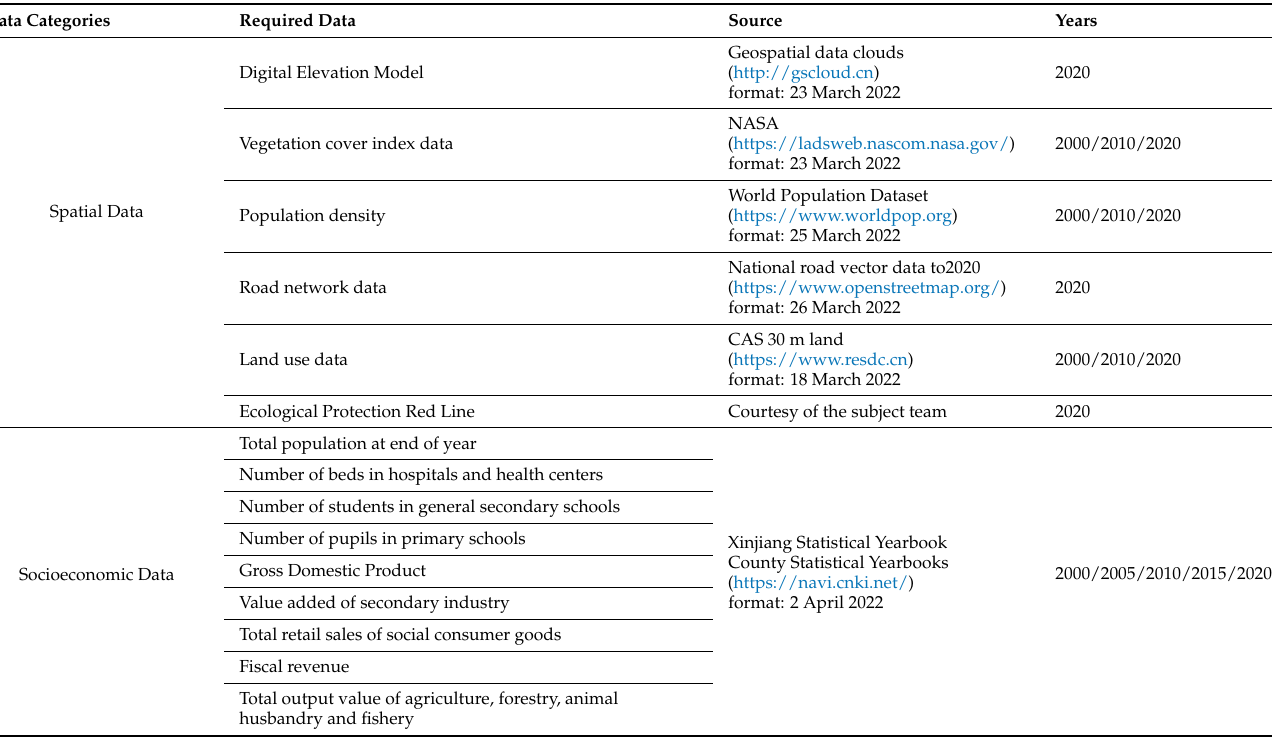
Table 1. Data required and their